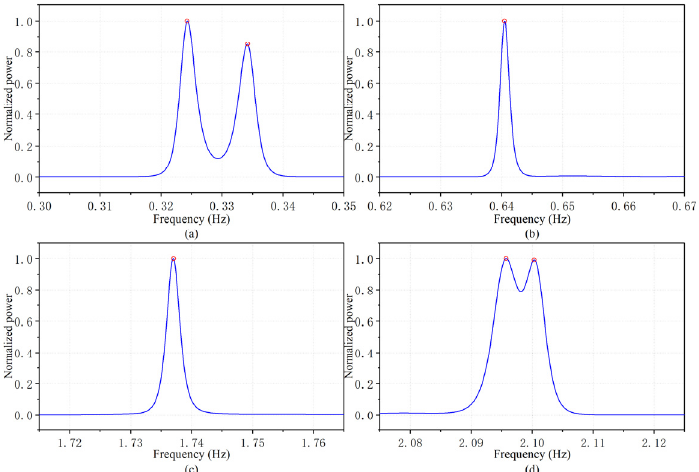
Figure 12. Results of practical data by IAA. The red circles indicate estimated frequencies. ( a ) Frequency band [0.30 Hz 0.36 Hz]; ( b ) frequency band [0.60 Hz 0.66 Hz]; ( c ) frequency band [1.70 Hz 1.76 Hz]; ( d ) frequency band [2.07 Hz 2.13 Hz].